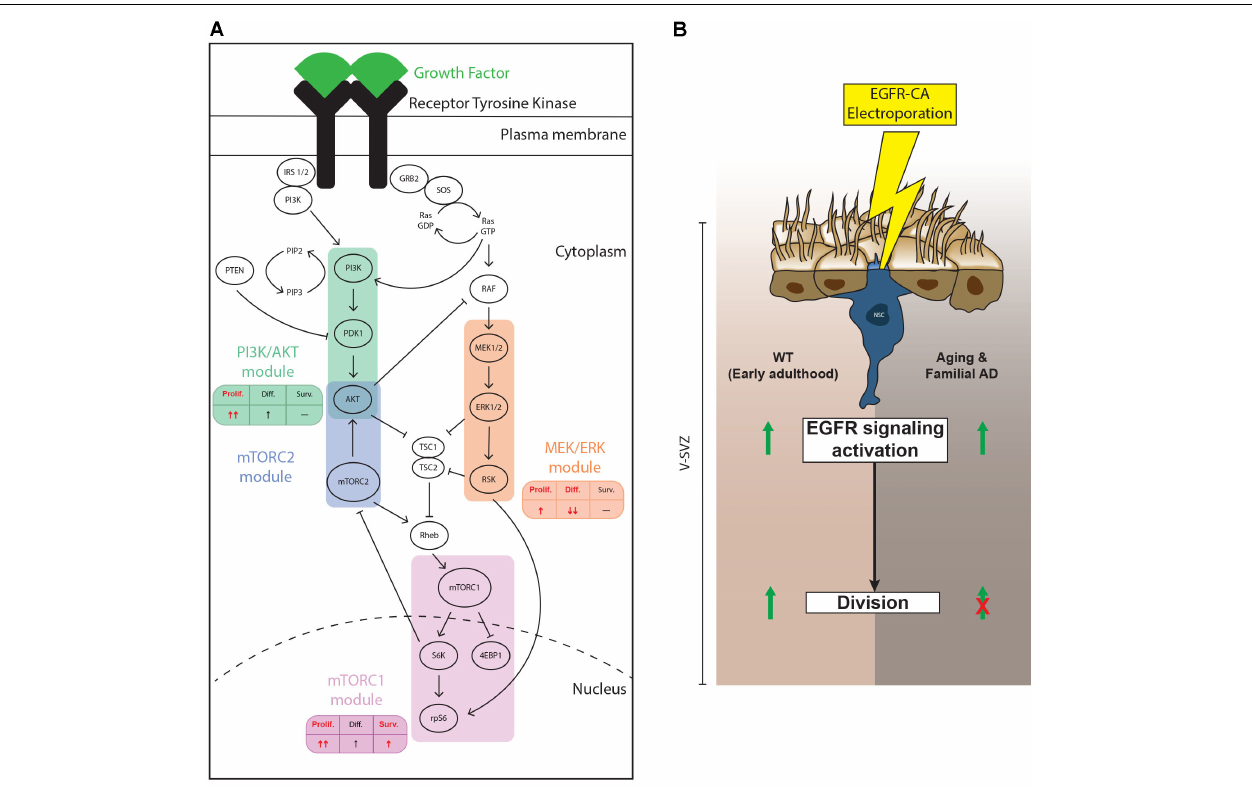
FIGURE 6 | Summary of findings. (A) Schematic showing the findings from our pharmacological loss-of-function experiments. In vitro , the PI3K/AKT, mTORC1/2 and, to a lesser extent, MEK/ERK, modules all contribute to EGF-induced NSPC proliferation. Only the mTORC1/2 modules showed evidence of contributing to NSPC survival, while only the MEK/ERK module mediated EGF-induced repression of NSPC differentiation. The effect of mTORC1 and mTORC1/2 modules did not significantly differ for these parameters, so we present only mTORC1. In each table, the main effect of each module is represented in red. (B) Effect of ectopic activation of EGFR-induced signaling in electroporated qNSCs. In young adult mice (left side of diagram), electroporation with EGFR-CA upregulates levels of pS6, a downstream marker of EGFR signaling and of “primed” qNSCs (Rodgers et al., 2014) and promotes their cell cycle entry. EGFR-CA electroporation in qNSCs of mice at middle age or in mice carrying familial Alzheimer’s disease (AD) mutations (right side of diagram) remains sufficient to activate EGFR-induced pS6, but these qNSCs do not undergo cell division. Thus, the antiproliferative signals associated with aging and AD are dominant to the pro-proliferative effects of EGFR-induced signaling